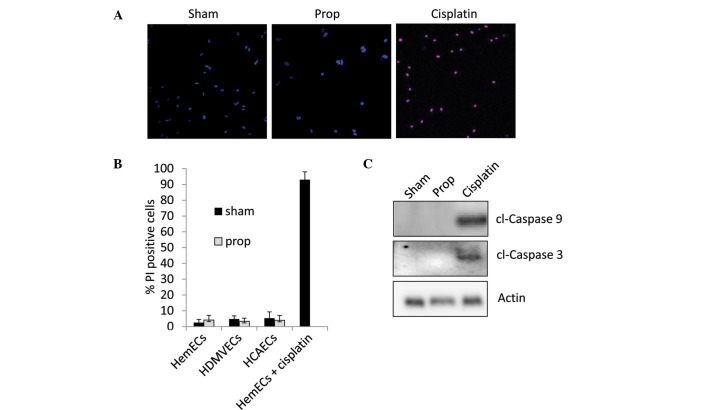
Propranolol does not induce apoptosis in human infantile hemangioma endothelial cells (HemECs) at its effective inhibitory concentration. (A) Confocal imaging of HemECs treated for 72 h with sham or 50 μM propranolol and subsequently co-stained with propidium iodide (PI) and Hoechst dye (blue, Hoechst-positive nuclei; pink, Hoechst-positive/PI-positive nuclei). (B) Quantification of PI-positive nuclei in HemECs, human dermal microvascular endothelial cells (HDMVECs), and human coronary artery endothelial cells (HCAECs) treated for 72 h with sham or 50 μM propranolol. (C) Western blot analysis detecting the levels of cleaved caspase-9 and -3 (cl-caspase-9 and cl-caspase -3, respectively). Actin levels were used as a loading control.